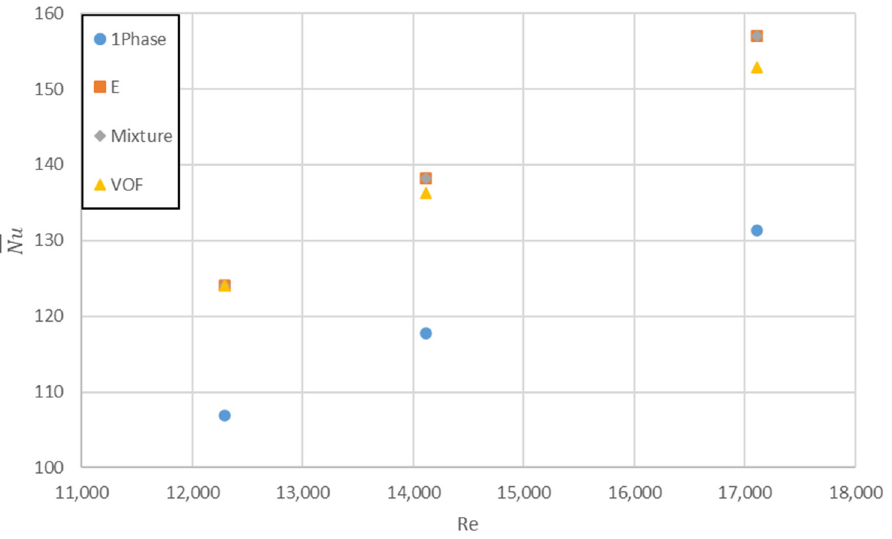
Figure 3. Nu-Re relationship for water–Al 2 O 3 (1%) nanofluid—data source Figure 3. Nu(cid:3364)(cid:3364)(cid:3364)(cid:3364) ‐ Re relationship for water–Al 2 O 3 (1%) nanofluid—data source [29].